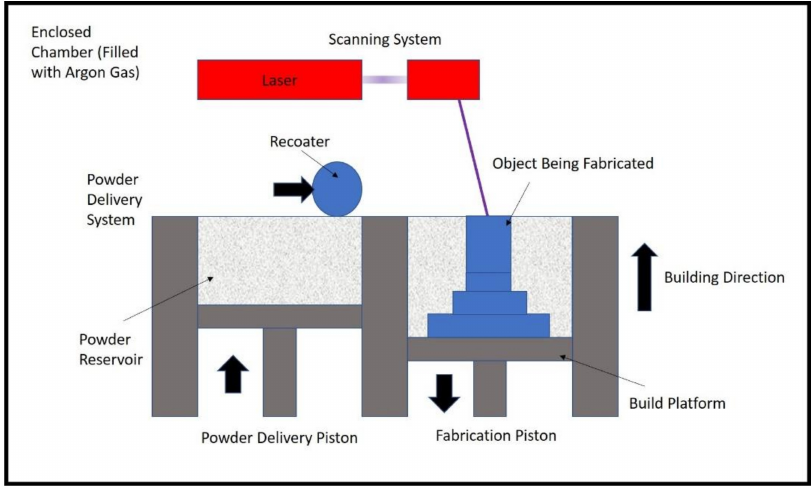
Figure 1. Schematic diagram of the selective laser melting (SLM)